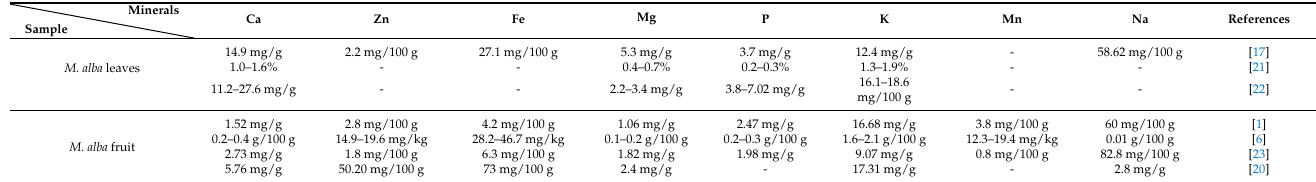
Table 2. Mineral contents in M. alba